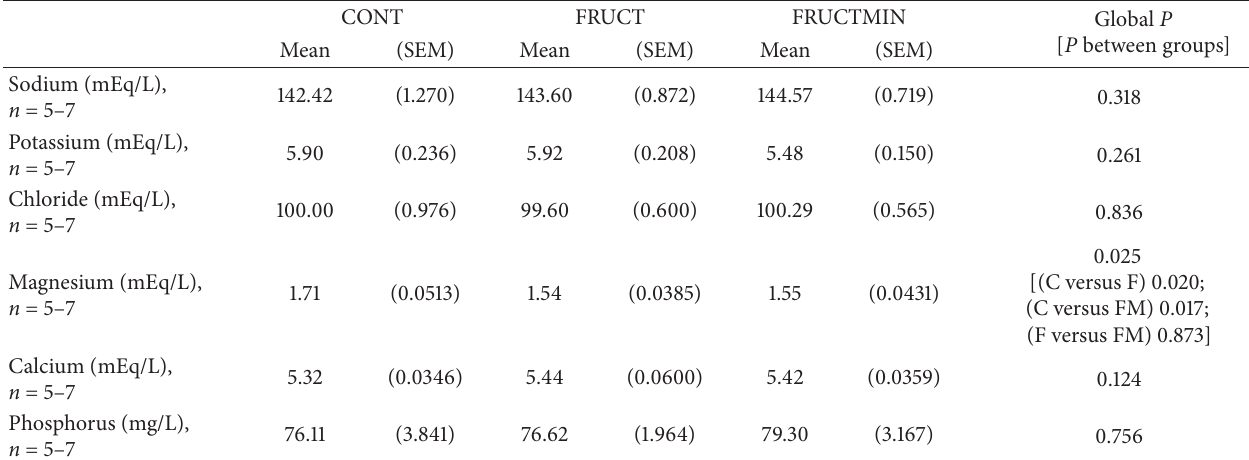
Table 3: Plasma electrolyte content, at the end of the dietary intervention. CONT FRUCT FRUCTMIN Global P